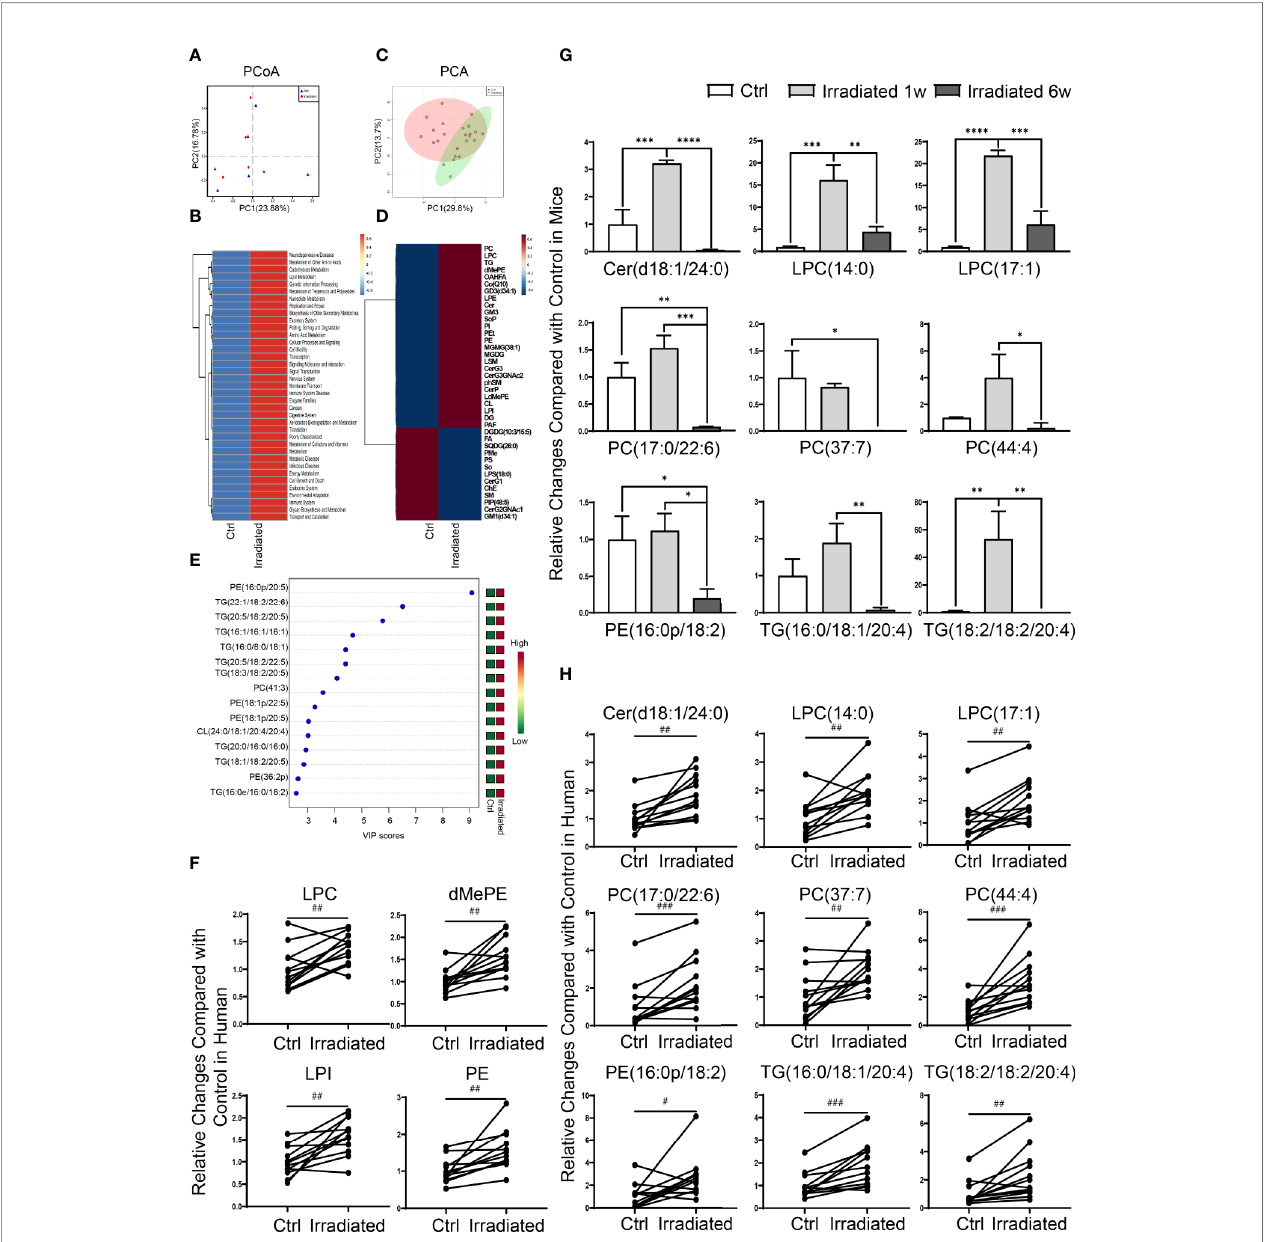
FIGURE 6 | Characteristic gut microbial and lipidomic pro fi le changes in RE patients. (A) PCoA scores plot based on OTU level. (B) Functional capabilities of microbial communities predicted by PICRUSt based on 16S datasets. (C) PCA scores plot based on lipid metabolites. (D) Clustering patterns of serum lipid metabolite types in irradiated and unirradiated patients displayed by hierarchical clustering heatmap. (E) The top 15 serum lipid metabolites signi fi cantly related to RE were identi fi ed by OPLS-DA. (F – H) Four lipid categories and nine lipid metabolites show the consistent variation trends in both human and mouse in RE. Signi fi cance levels are indicated as follows: ****q < 0.0001, ***q < 0.001, **q < 0.01, *q < 0.05; ### p < 0.001, ## p < 0.01, # p <